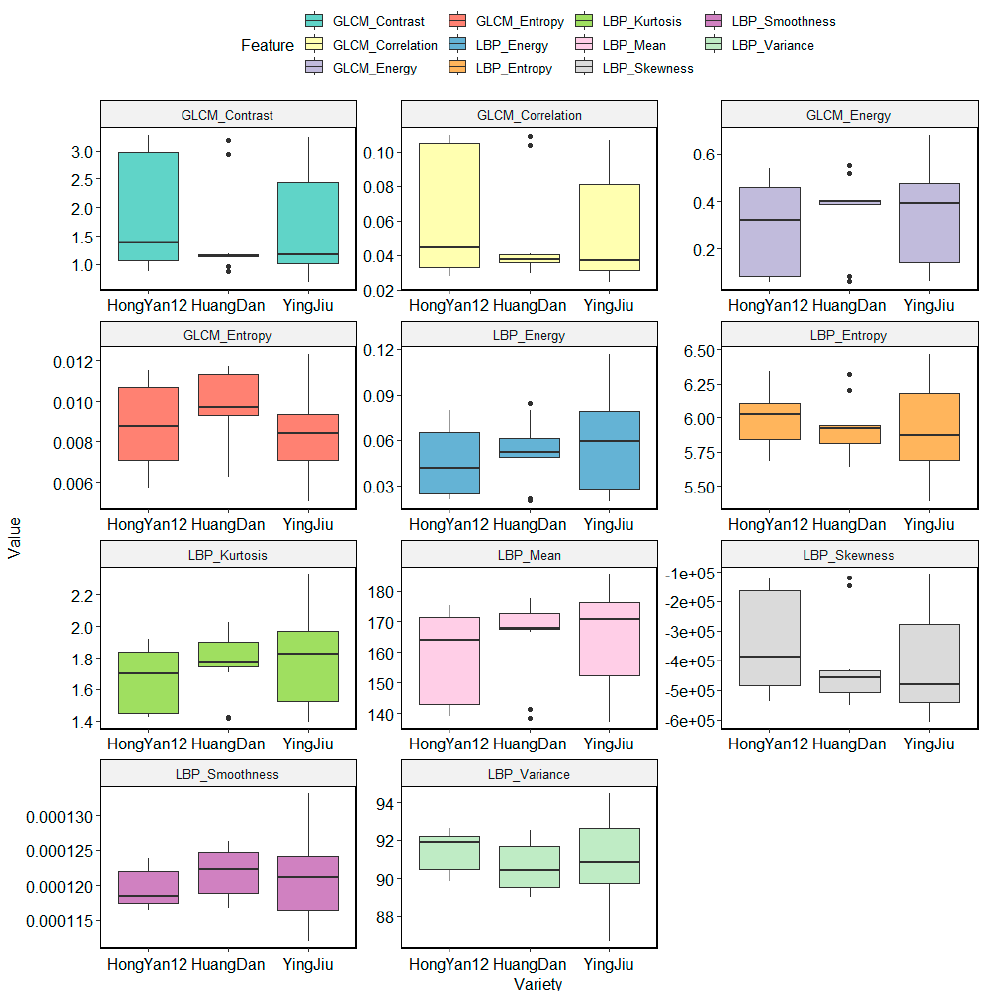
Figure 9. Distribution of texture features of different tea varieties.